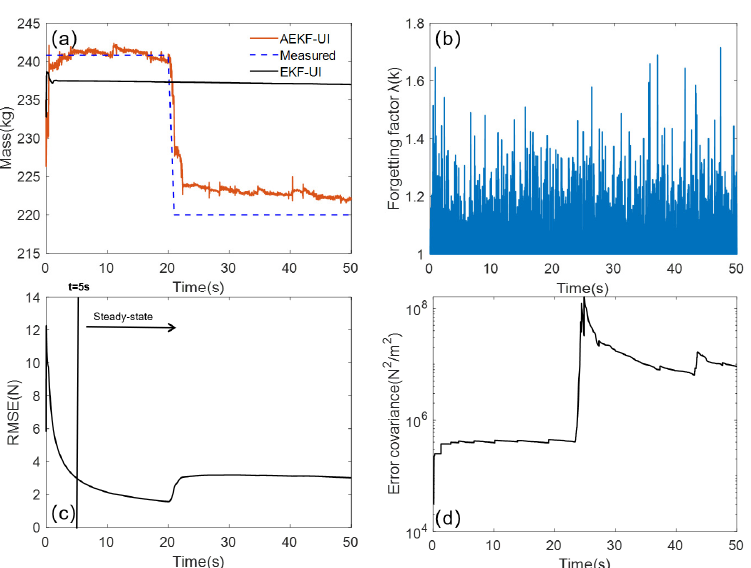
Figure 6. Simulation result of vehicle mass estimation; ( a ) estimated vehicle mass (240 kg → 220 kg from 20 to 21 s), ( b ) time evolution history of the forgetting factor, ( c ) RMSE (AEKF − UI), and ( d ) convergence history of error covariance.